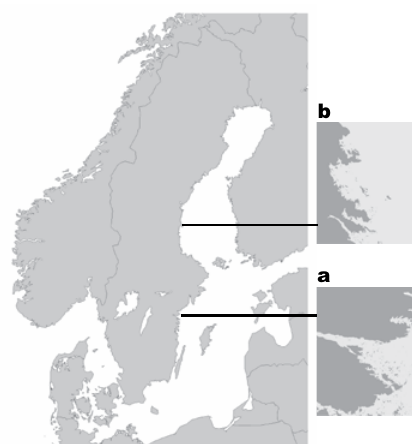
Fig. 2. Map of the Baltic region and the study areas at (a) Nävekvarn and (b) Skärså.